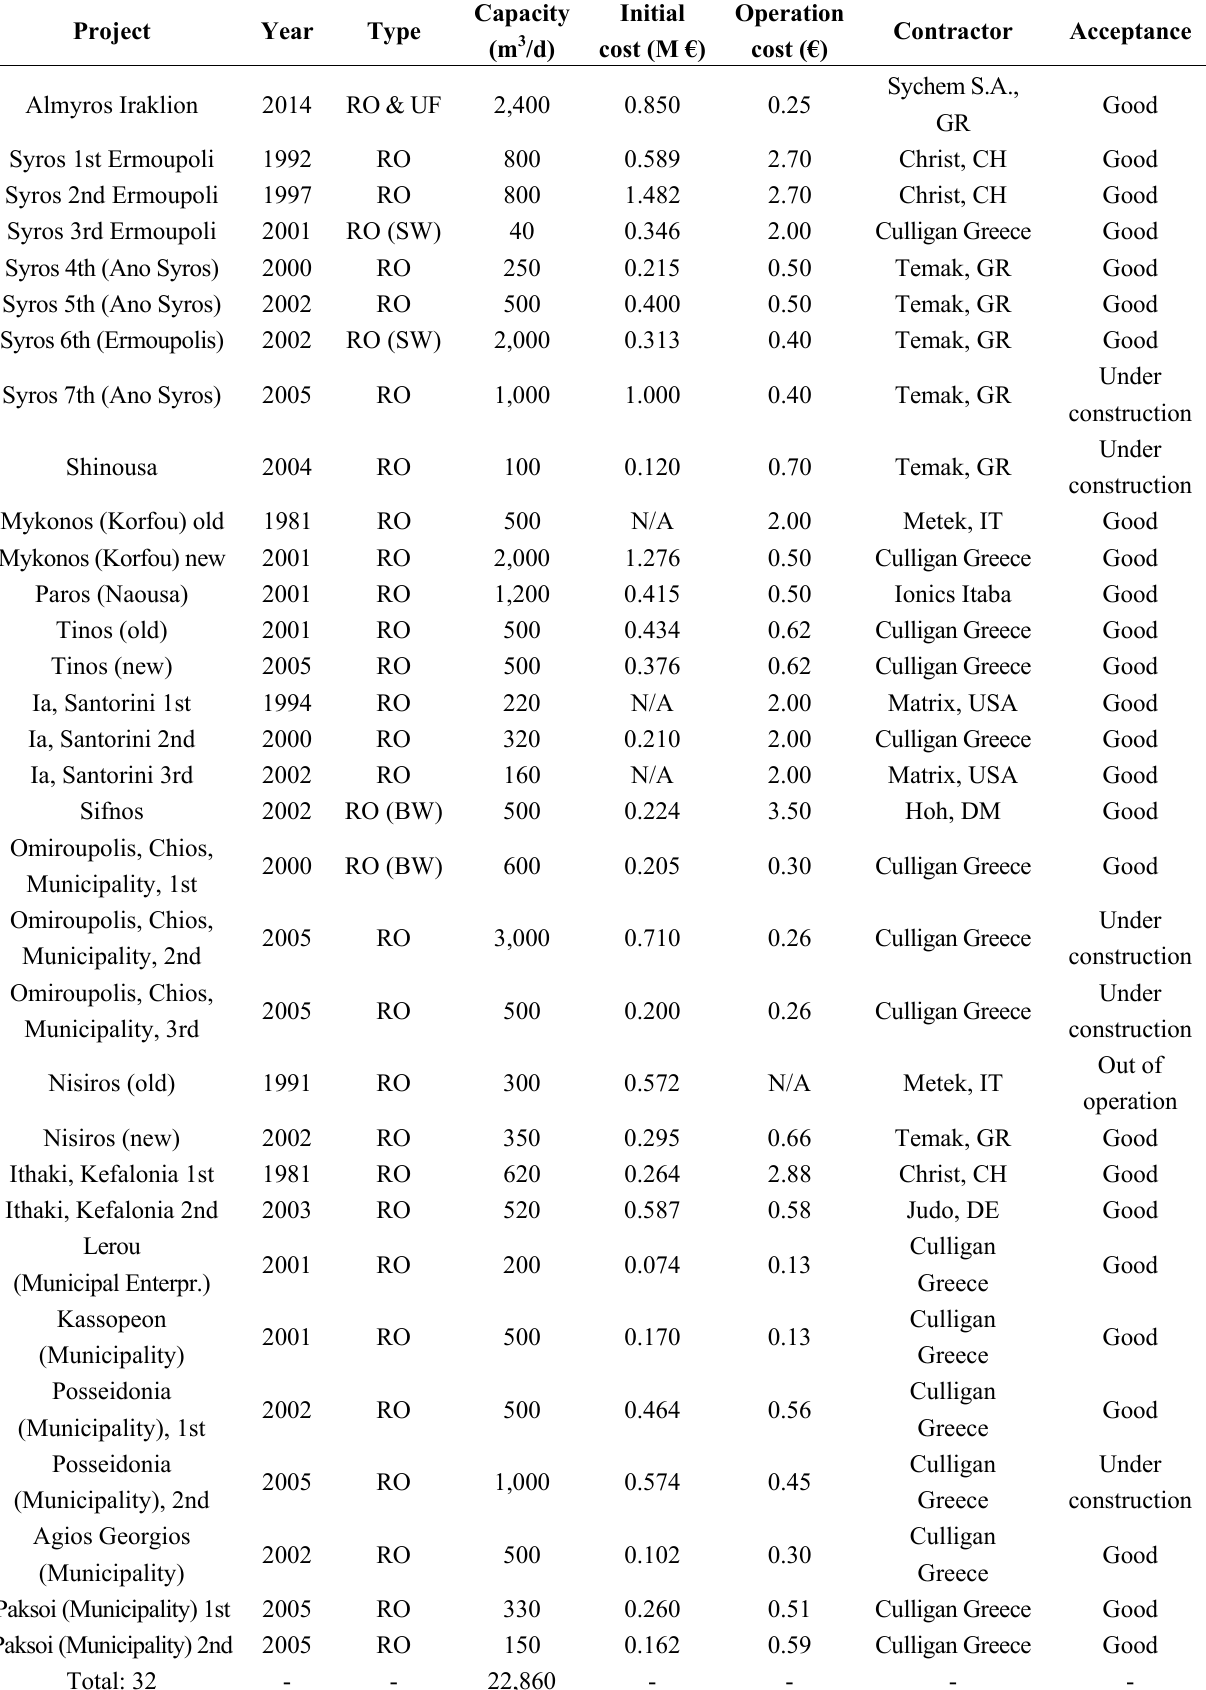
Table 7. RO desalination plants in Hellenic islands’ municipalities. Adapted from